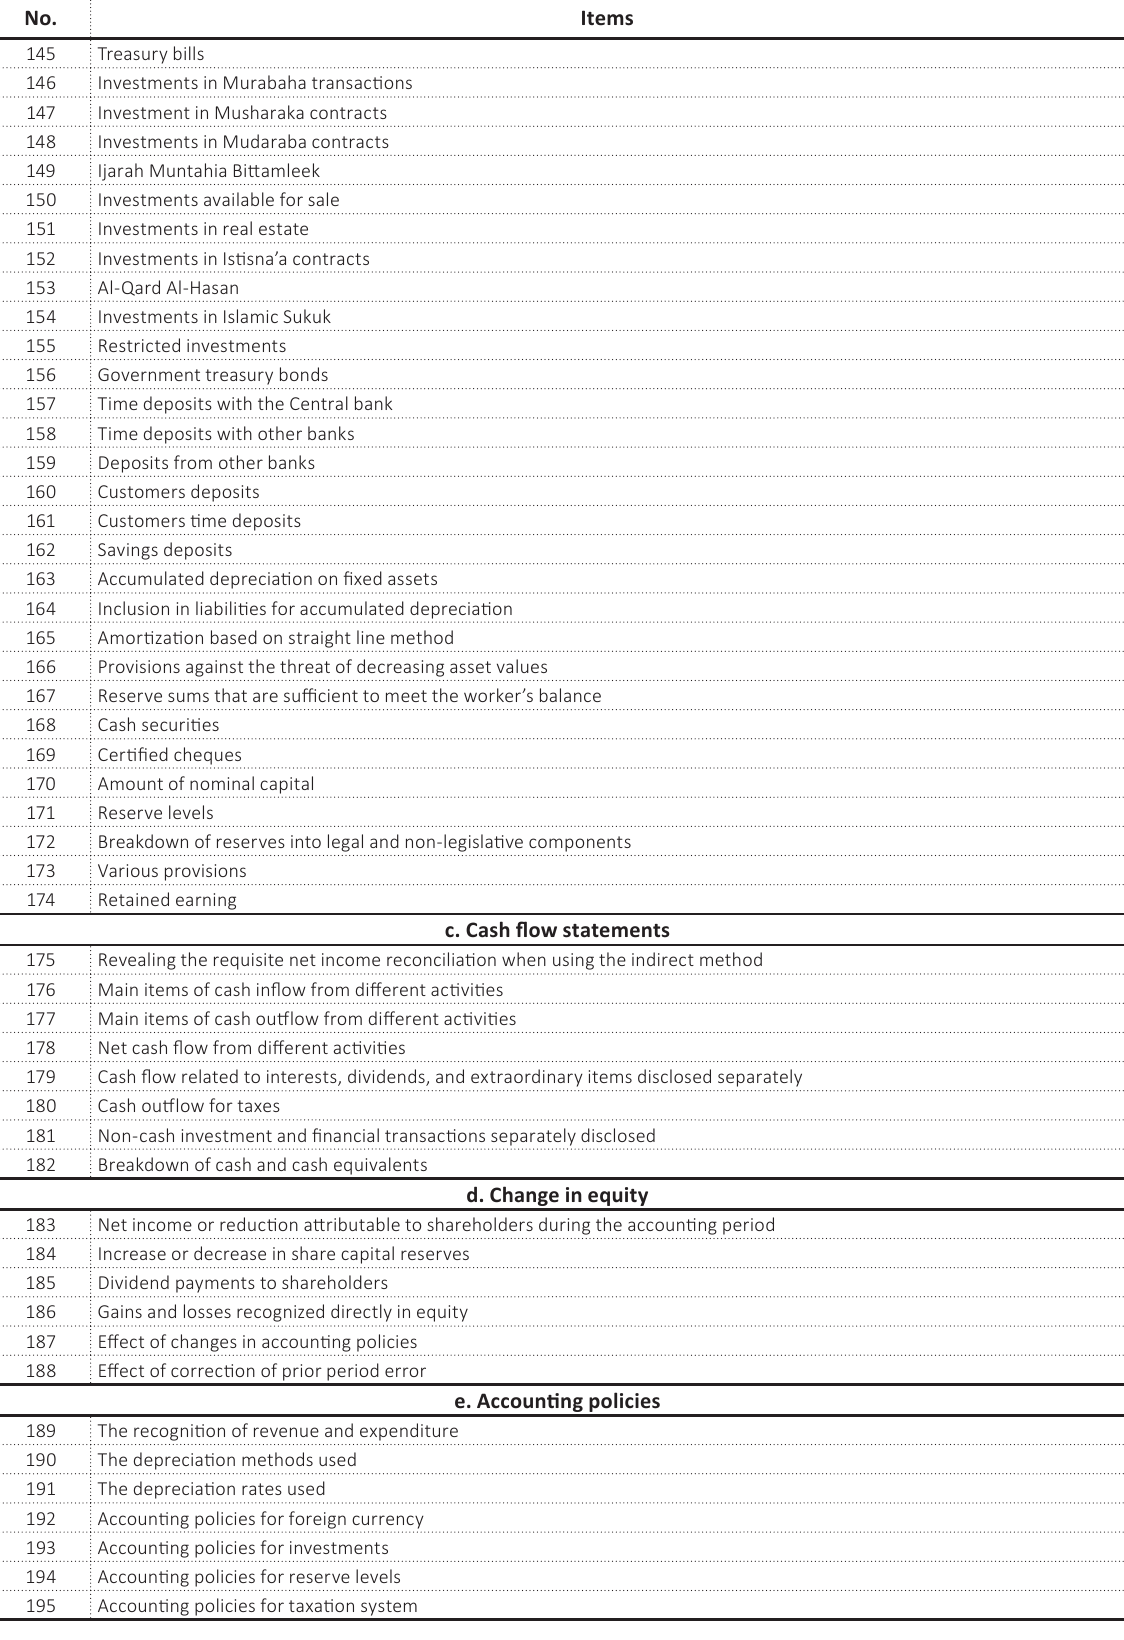
Table A1. (cont.) Voluntary disclosure index